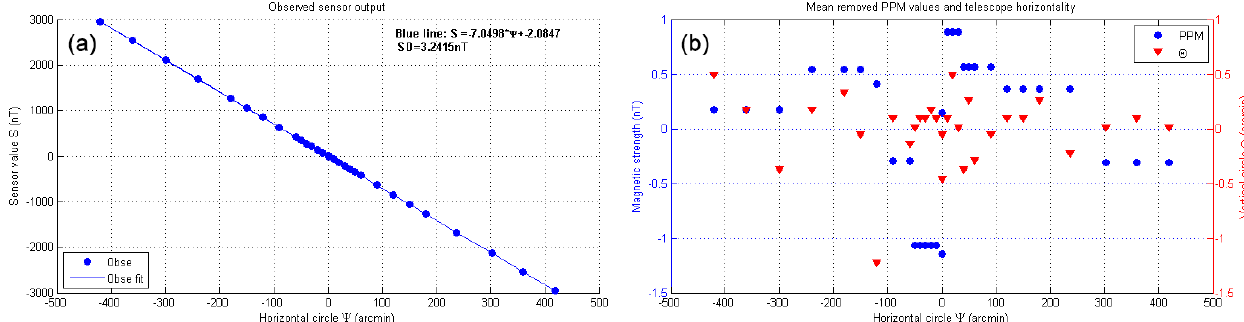
Figure 2. FluxSet magnetometer is linear inside the ± 3000nT range and the observations deviate with 3.2nT from the calculated line (a) , while the scalar (PPM) readings changed by a maximum of 2nT during the 10min linearity check test (b) .